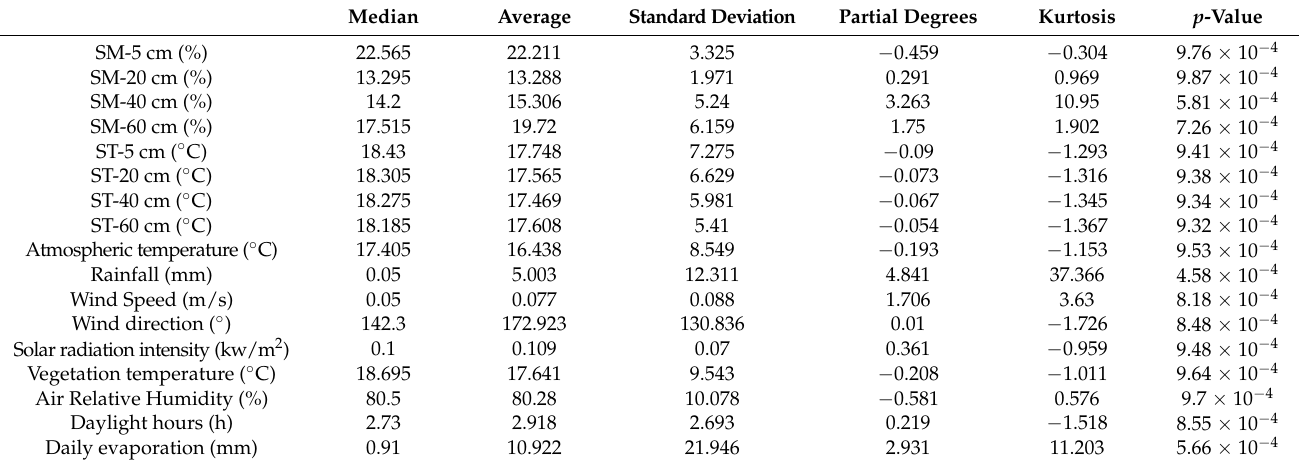
Table 4. Results of normality test for environmental